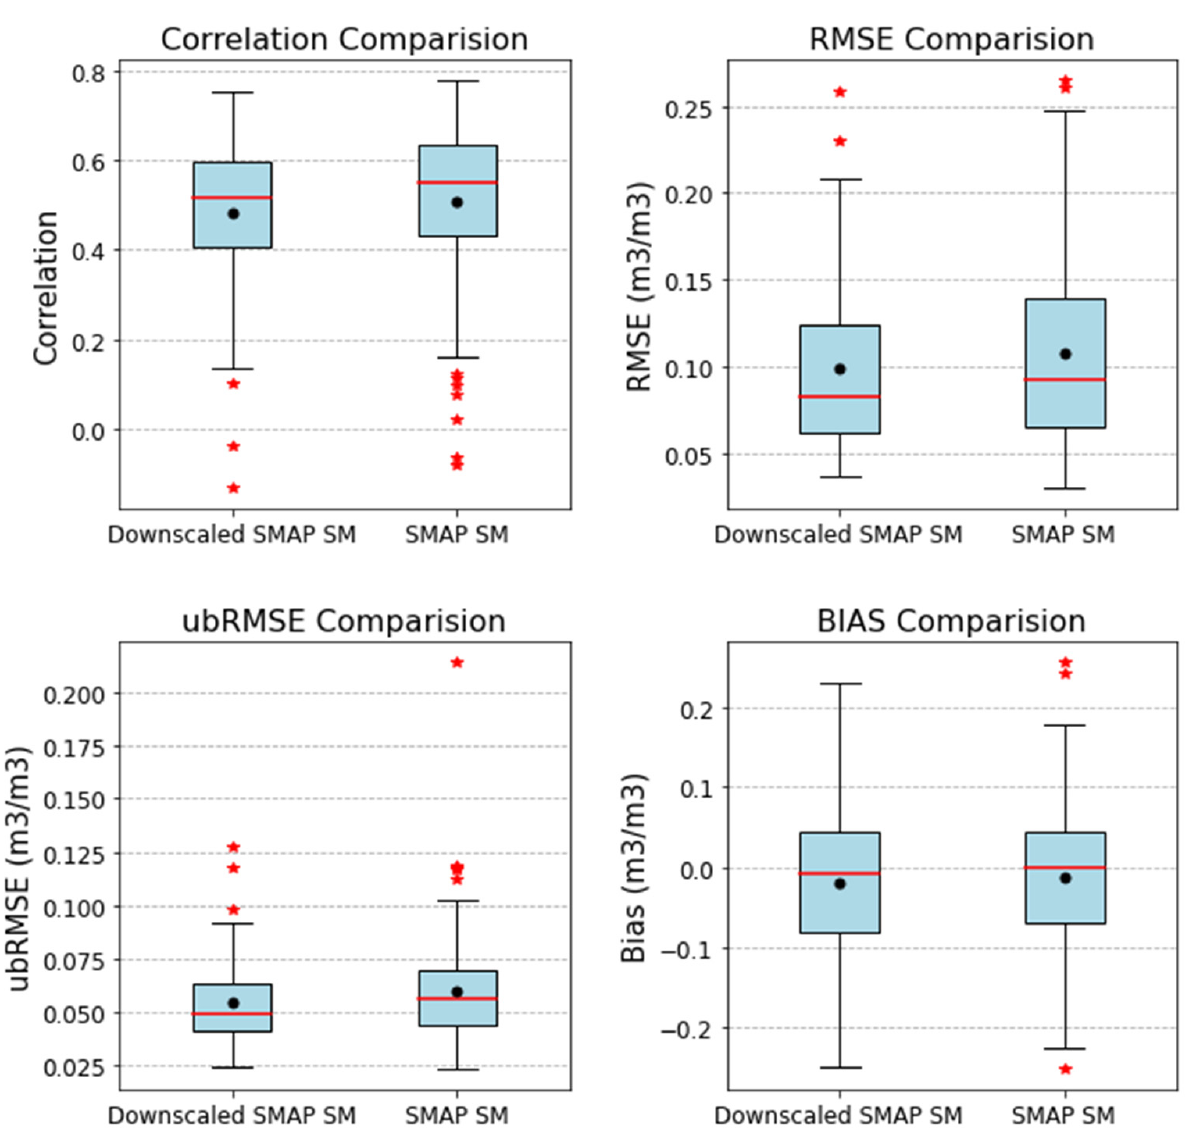
Figure 9. Box-plot of the in situ validations of the downscaled SM and the original SMAP SM. The red “*” are the outliers.